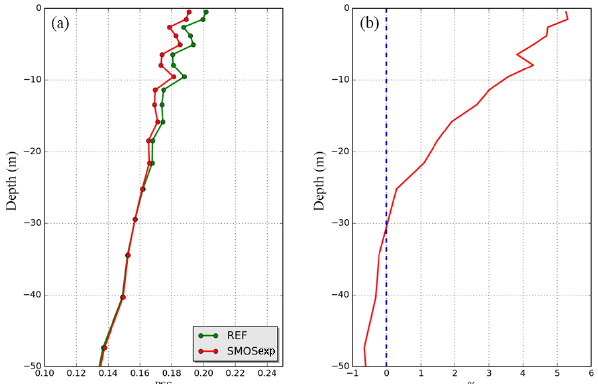
Figure 8. Average salinity RMSE (pss) compared to all in situ mea- surements (a) over the period 1 January 2014 to 2 March 2016 in the global domain for the REF (green line) and SMOSexp (red line) experiments as a function of depth over the top 50m. The corre- sponding percentage of RMSE difference in all in situ salinity mea- surements between REF and SMOSexp experiments (b) (positive difference implies a reduction in RMSE by the SSS